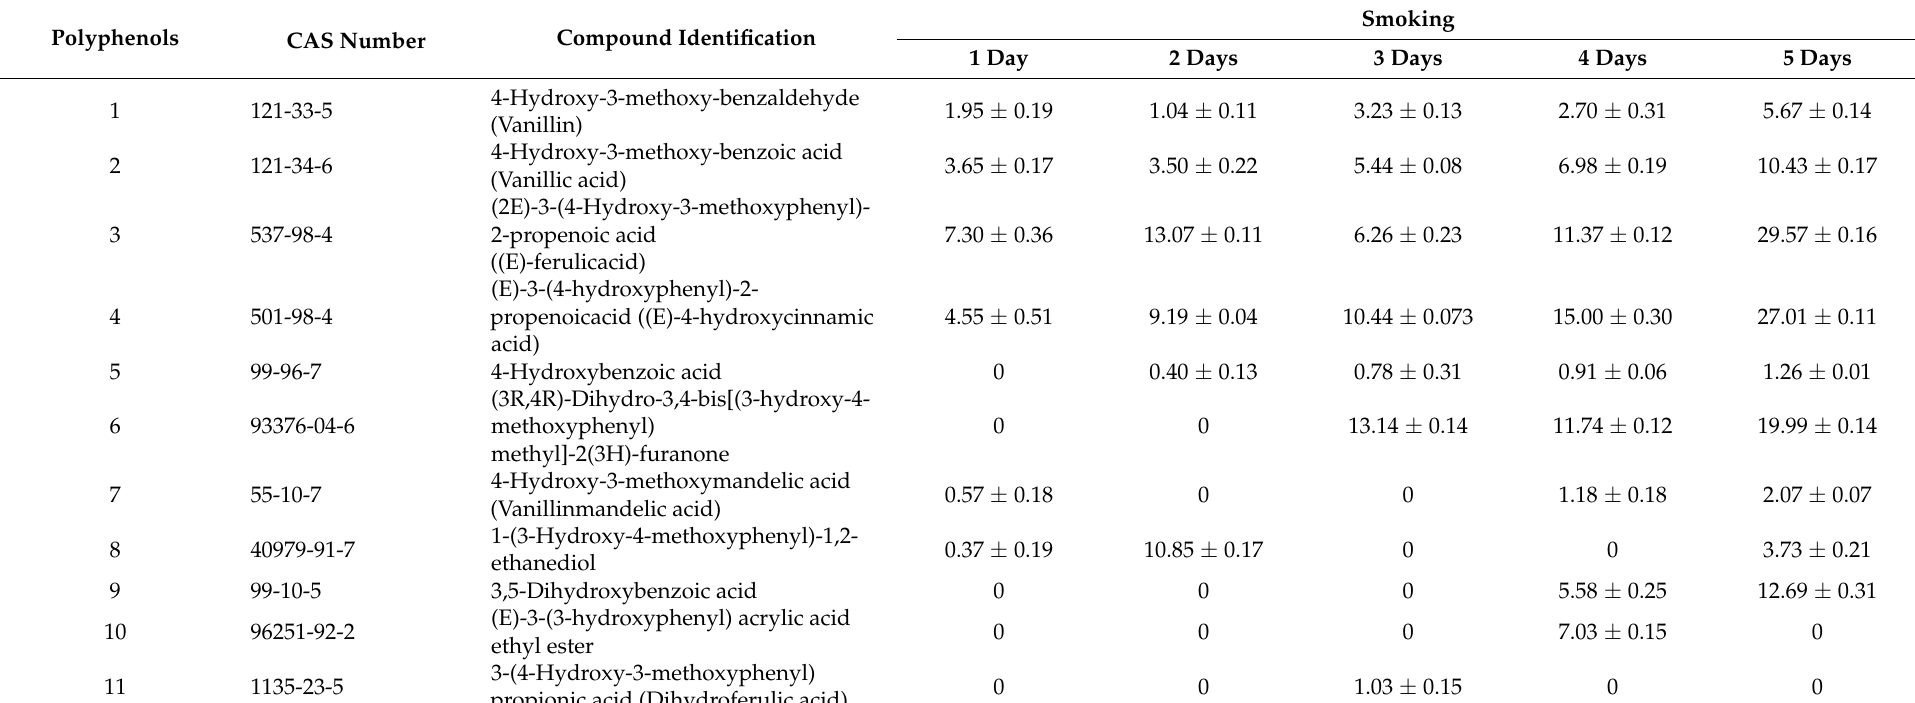
Table 1. Distribution of polyphenols during the smoking process of Shanxi aged